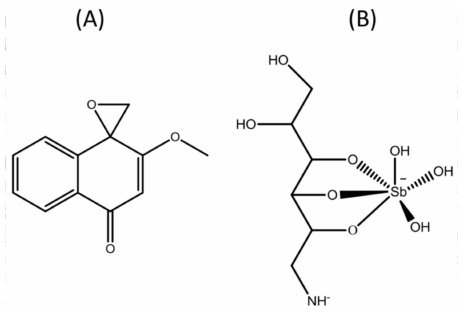
Figure 1. Chemical structure of drugs. ( A ) 2-methoxy-4H-spiro[naphthalene-1,2 (cid:48) -oxiran]-4-one, also known as Epoxymethoxy-lawsone (C 12 H 10 O 3 , 202.21 g/mol) and ( B ) meglumine antimoniate known commercially as Glucantime ® (C 7 H 18 NO 8 Sb, 365.98 g/mol—structure proposed by Fr é zard et al. [15]).